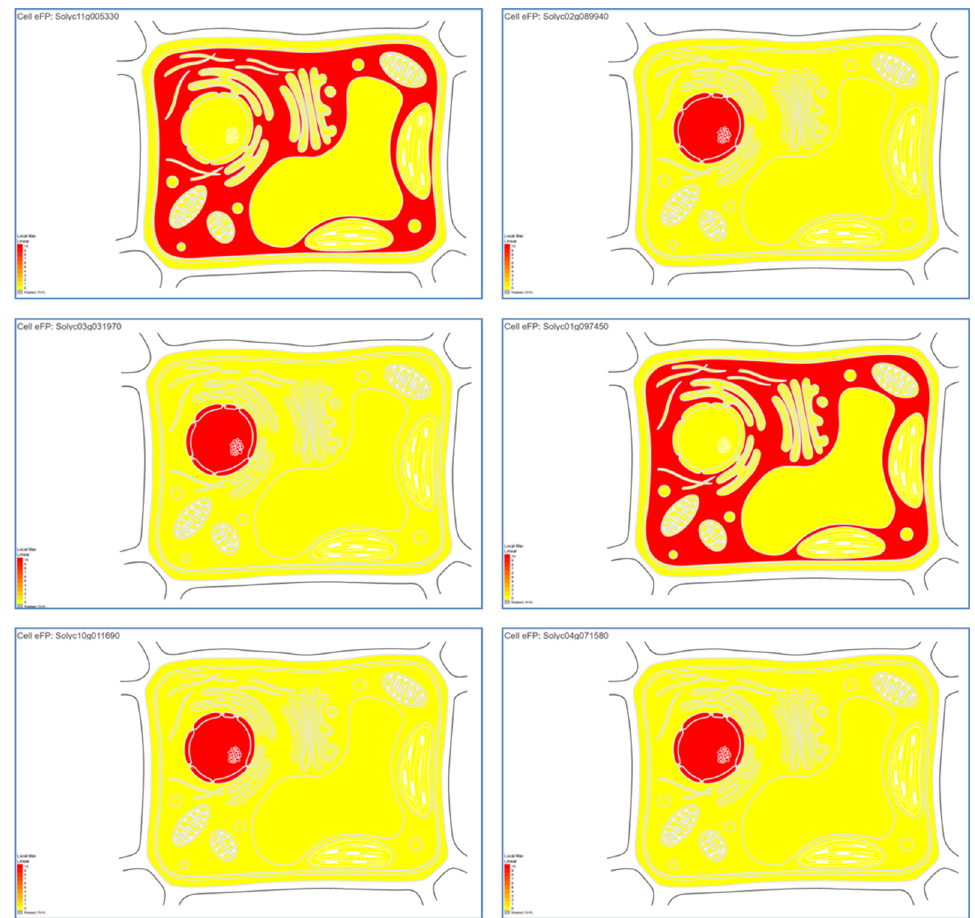
Figure 4. Putative subcellular localizations of the genes and/or’ proteins for different cell organs using Cell eFP browsers in Tomato plant. The more intense the red color of the expression bar, the more gene expression detected [ 43 ] .